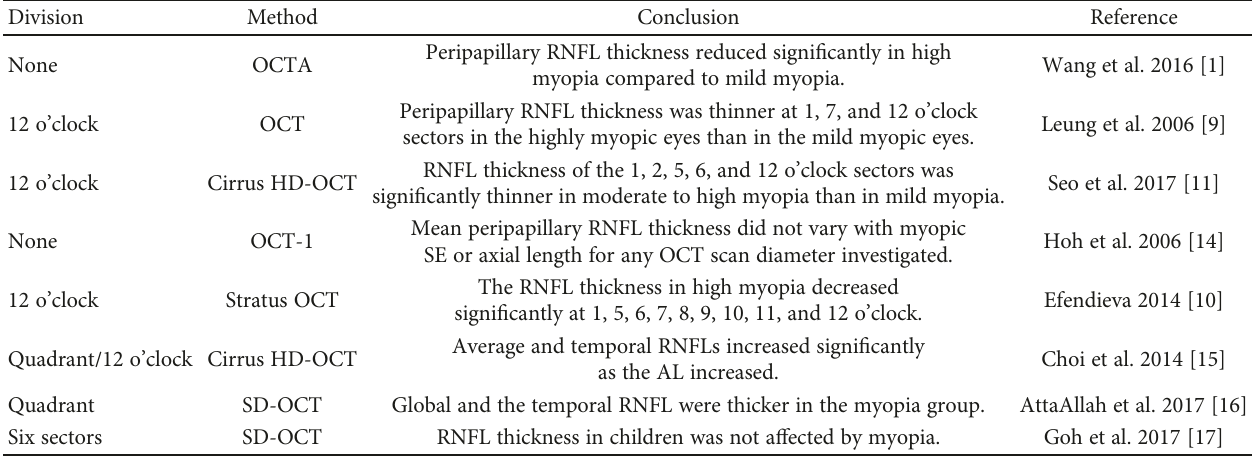
Table 4: Comparison of OCT-based RNFL thickness studies in the myopic eyes. Division Method